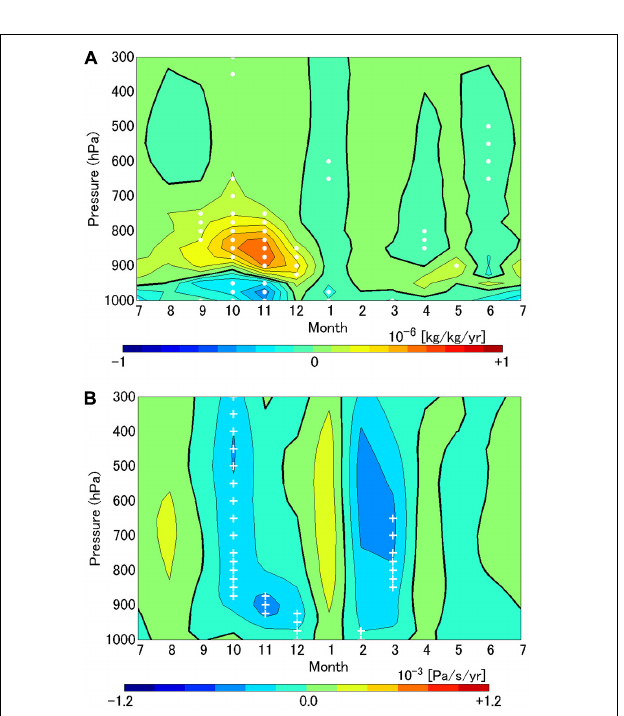
FIGURE 13 | Trends of (A) cloud water mixing ratio and (B) vertical velocity averaged over the area of 68.0–72.5 ◦ N and 167.5–174.0 ◦ W (black solid rectangle in Figure 2A ) in the Chukchi Seafor 1979–2020. Black bold lines are zero contours. White dots in (A) and pluses in (B) denote statistical significance at the 95 and 90% confidence level, respectively.